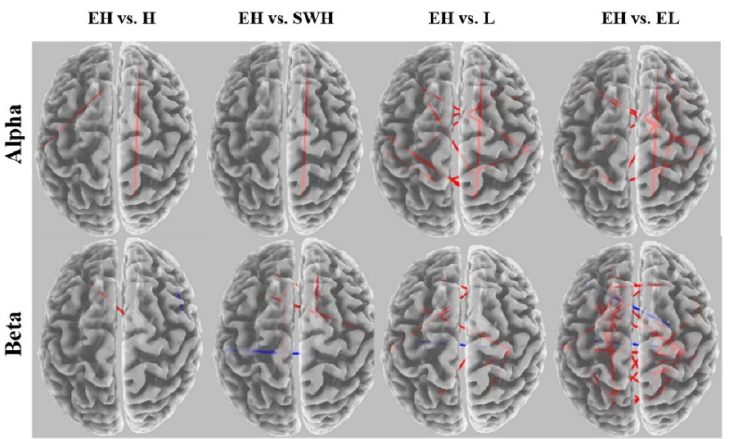
Figure 9. eLORETA wire diagram comparing extremely hard exertion with other exertion levels for each frequency band. EL: extremely light, L: light, SWH: somewhat hard, H: hard, and EH: extremely hard.